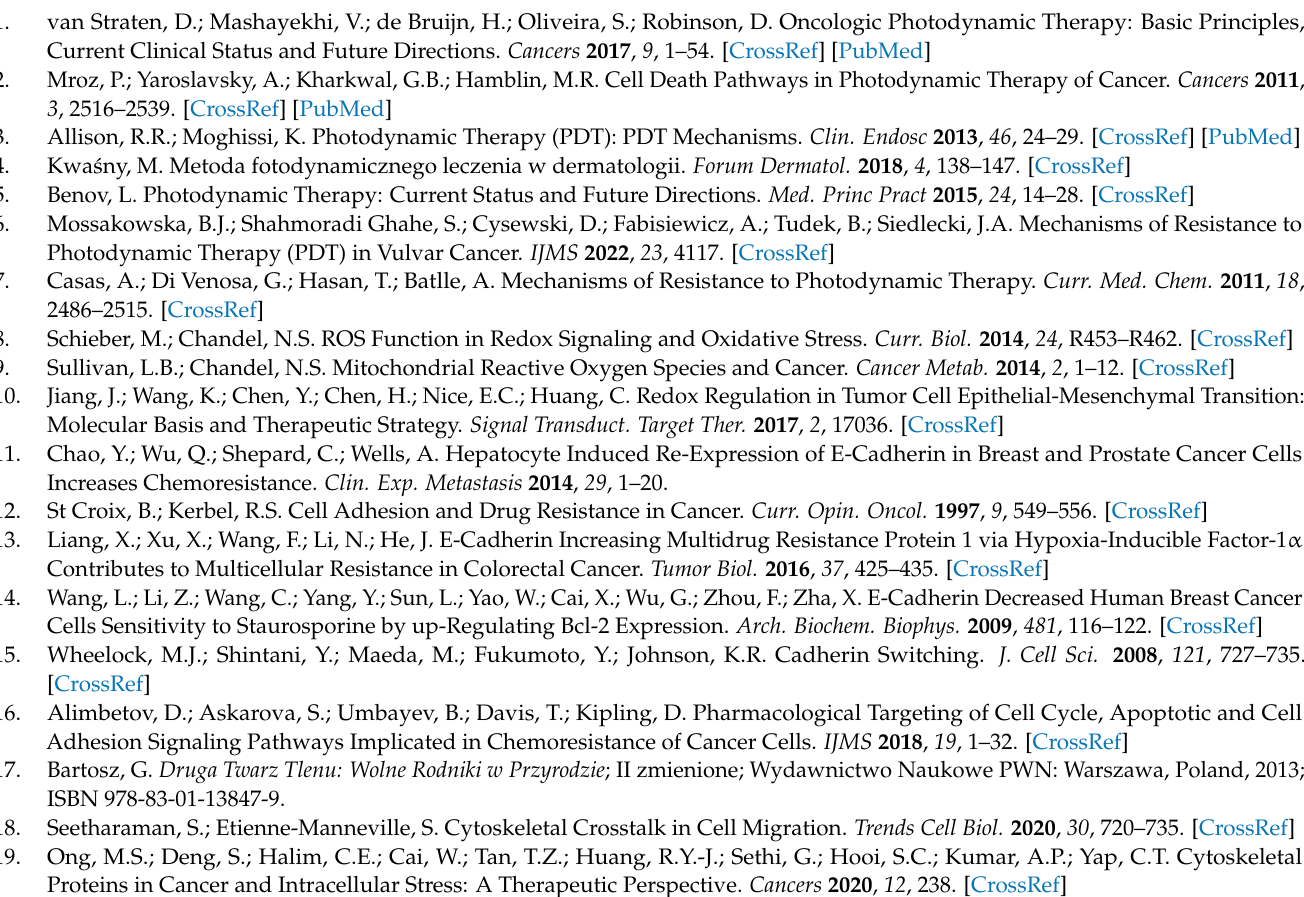
Table S12: Changes in the level of proteins involved in antigen processing in resistant A-431 cells; Table S13: Changes in the level of proteins involved in antioxidant defense in resistant CAL-39 cells; Table S14: Changes in the level of proteins involved in vesicular transport in resistant CAL-39 cells; Table S15: Changes in the level of proteins involved in RNA processing in resistant CAL-39 cells; Table S16: Changes in the level of proteins involved in RNA processing in resistant A-431 cells;